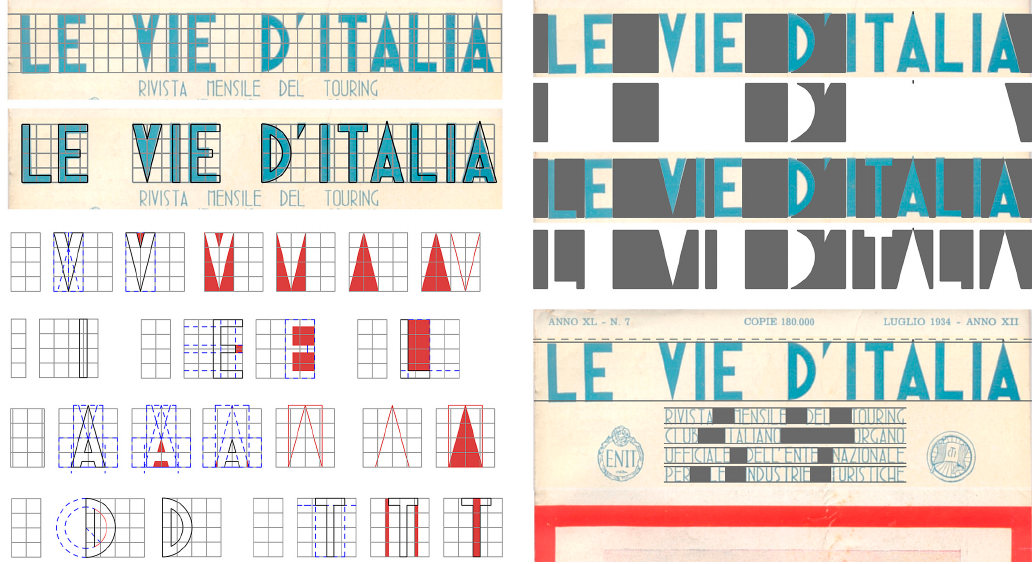
Figure 7. The new graphical look of the magazine renewed in 1933. The design of the characters, the kerning, the spacing between the words and the interline spacing.